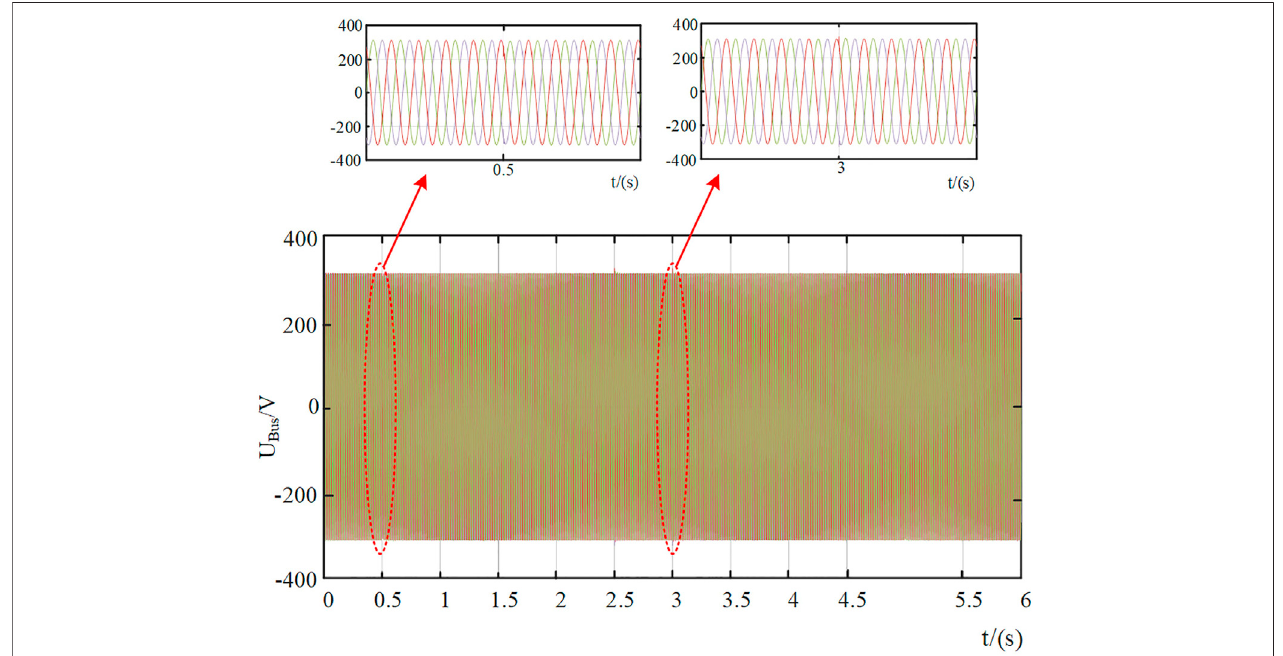
FIGURE 8 | Compensated node voltage